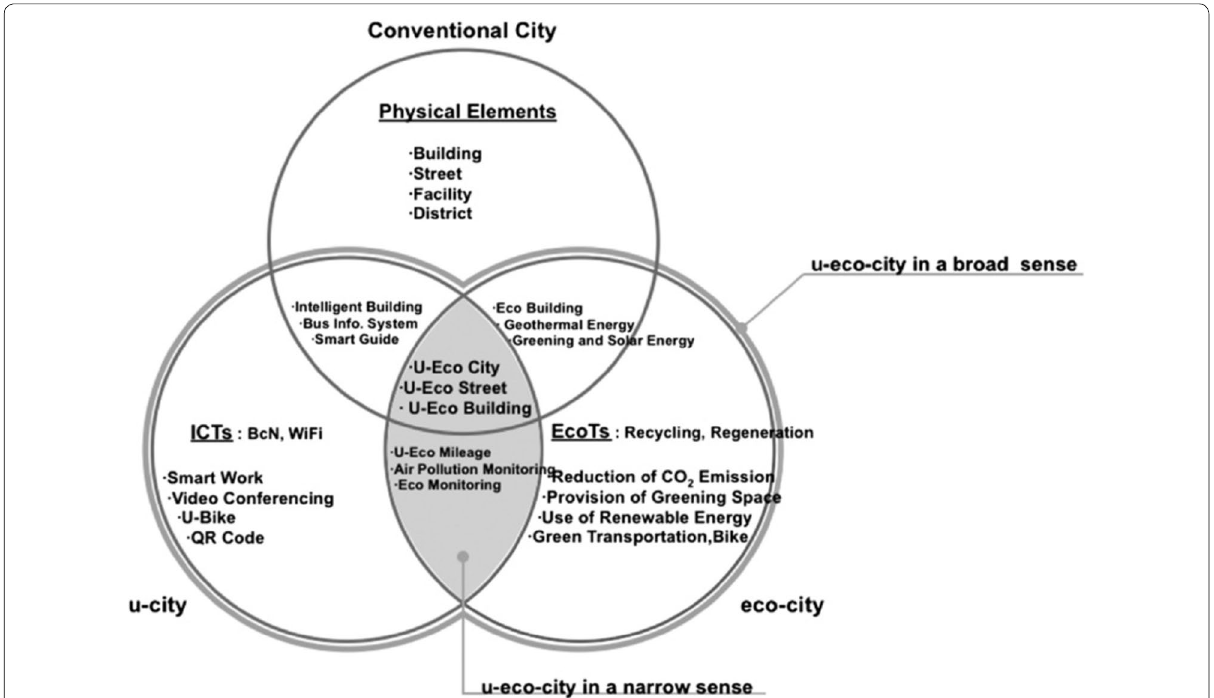
Fig. 2 Relation between ubiquitous-city and eco-city in the context of u-eco-city (source: Yigitcanlar and Lee